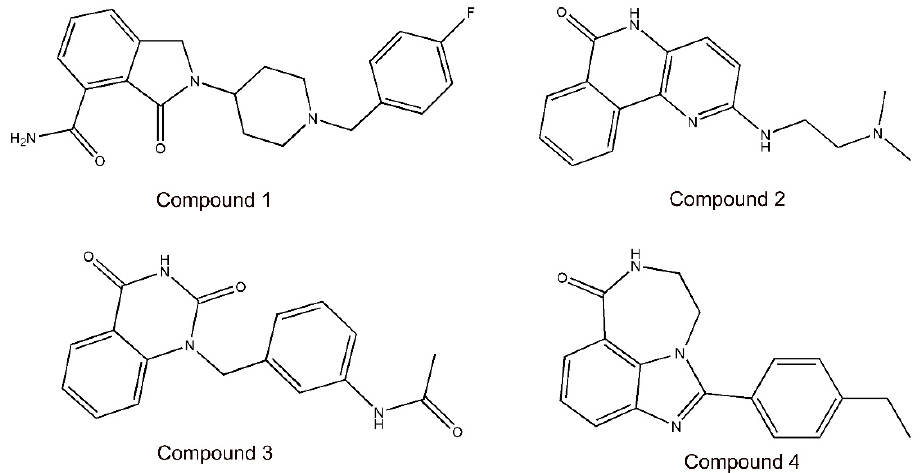
Figure 3. The chemical structures of four selected compounds ( 1 – 4 ).